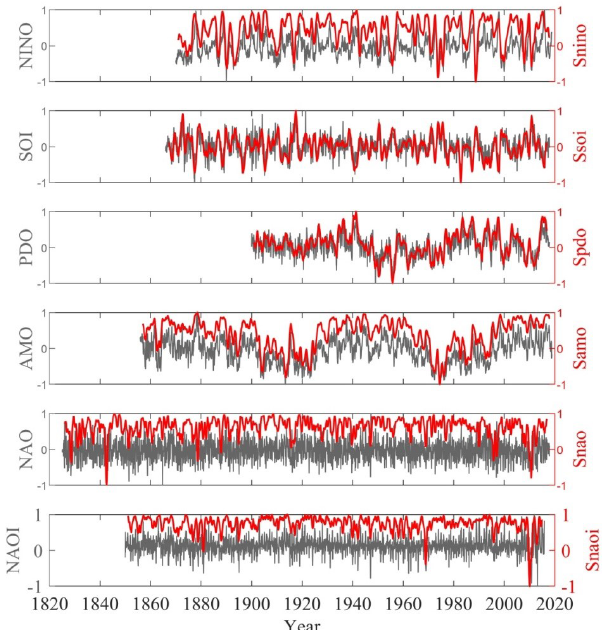
Figure 1. Normalized monthly time series of six climate indices during each period (gray lines): NINO (01/1870–12/2018), SOI (01/1866–12/2017), PDO (01/1900–12/2017), AMO (01/1856– 12/2018), NAO (01/1825–12/2017), and NAOI (01/1850–12/2015) with their corresponding SFA-derived slow feature signals (red lines), which are indicated by Snino, Ssoi, Spdo, Samo, Snao, and Snaoi, respectively (setting embedding dimension m to be